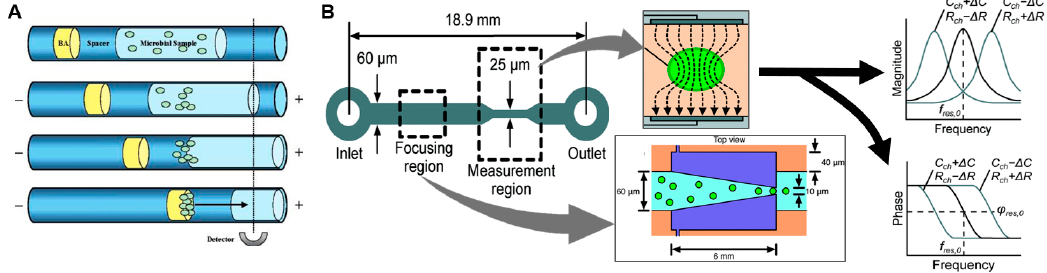
Figure 3. Microfluidic methods for detection of bacteria. ( A ) A microbial sample with “universal” fluorescent stain is concentrated by capillary electrophoresis to improve detection